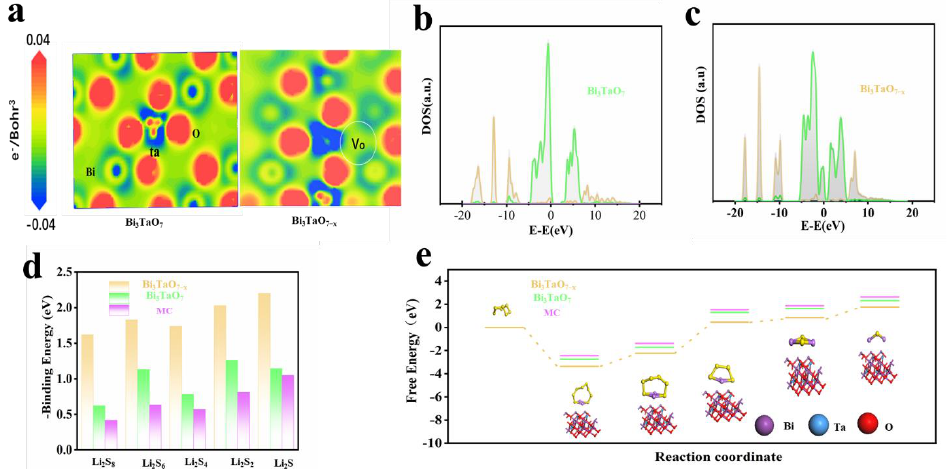
Figure 7. ( a ) The section of charge density difference of Bi 3 TaO 7 and Bi 3 TaO 7 − x . ( b , c ) The calculated DOS for Bi 3 TaO 7 and Bi 3 TaO 7 − x . ( d ) The binding energies between three samples and different LiPSs. ( e ) The Gibbs free energy from S 8 to Li 2 S on surface Bi 3 TaO 7−x , Bi 3 TaO 7 , and MC.